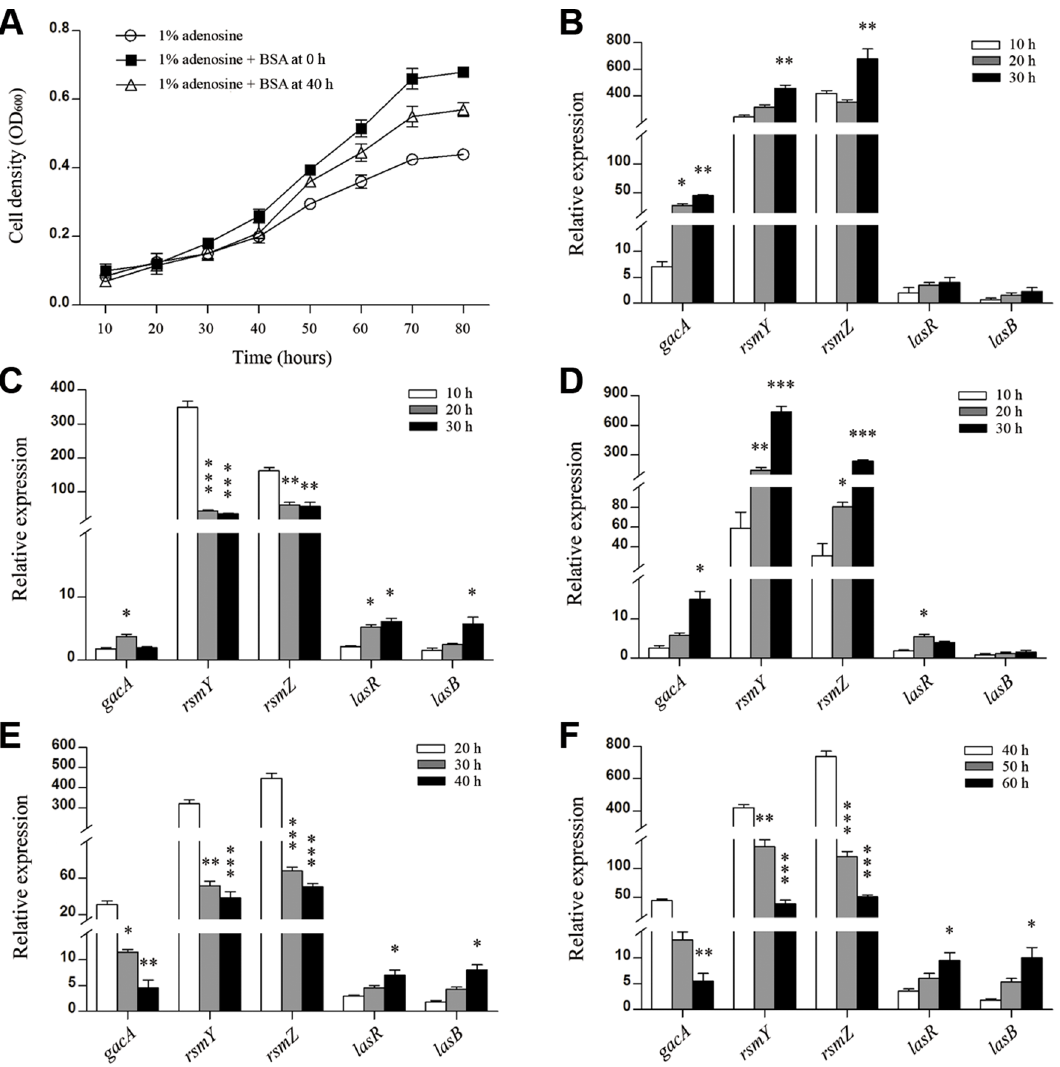
Figure 3. RsmYZ regulated cooperation was induced by environmental nutrient factors. (A) Growth of WT PAO1 in M9 minimal growth medium containing 1% adenosine (circle), 1% adenosine and 1% BSA as the dual carbon source (black square) and BSA was added after 40 hours cultivation (triangle). Expression of leadership and dependent genes of WT PAO1 were detected in M9 minimal growth medium containing (B) 1% adenosine; (C) 0.5% adenosine + 0.5% BSA; (D) 0.5% + 0.5% BSA and the supernatants were removed every 4 hours; (E) 1% adenosine and then 1% BSA was added after 20 hours cultivation; (F) 1% adenosine and then 1% BSA was added after 40 hours cultivation. Data are means 6 SEM, and representative of three experiments. *, P , 0.05; **, P , 0.01; ***, P , 0.001, one-way ANOVA (Tukey-Kramer post hoc).